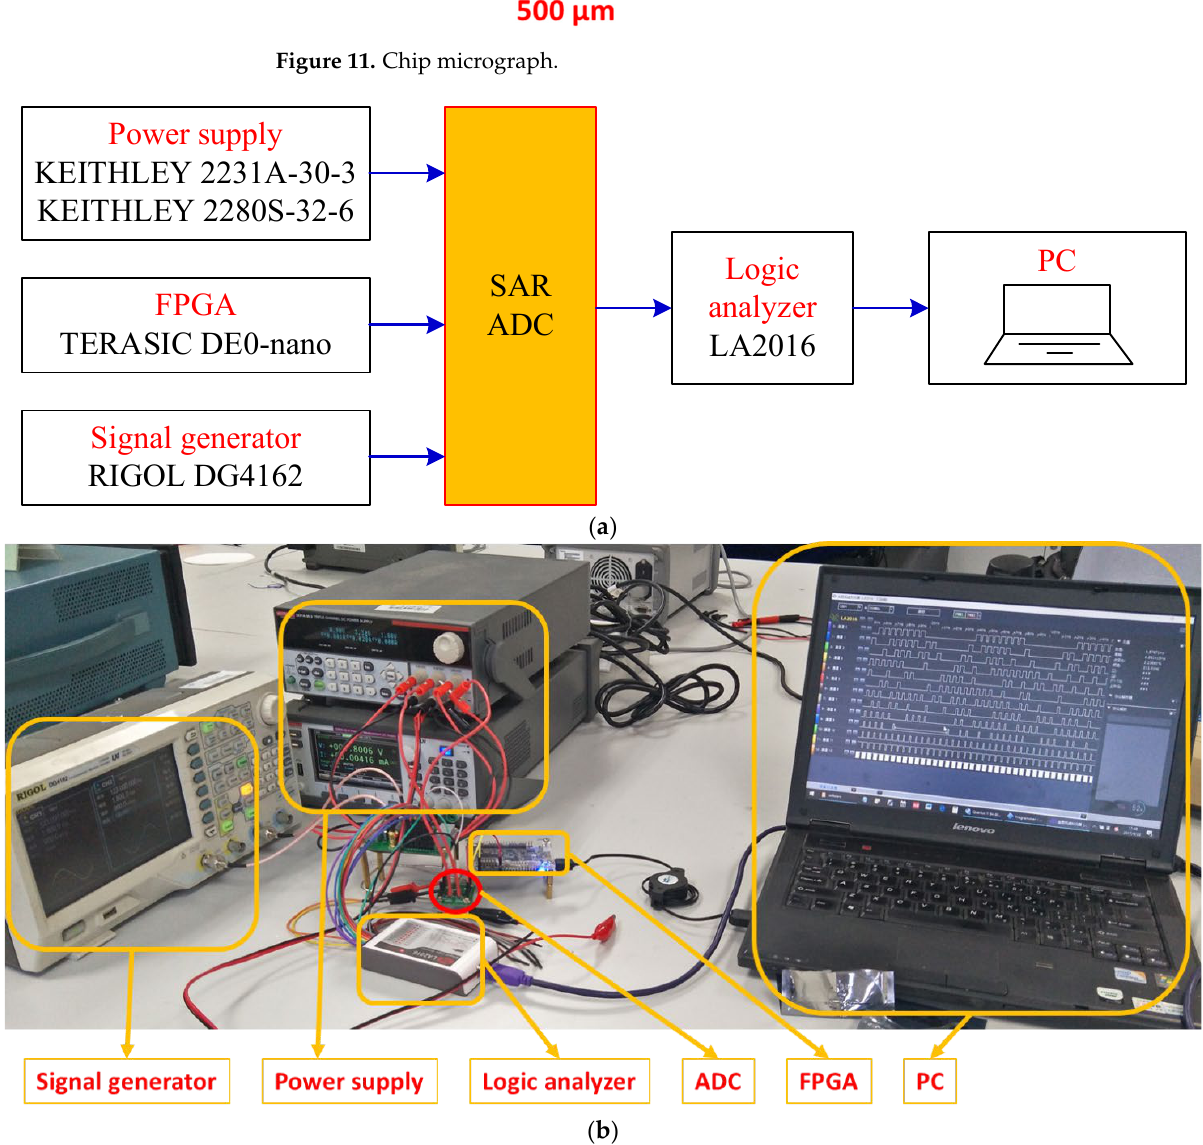
Figure 12. Measurement environment. ( a ) Block diagram; ( b ) Photo.